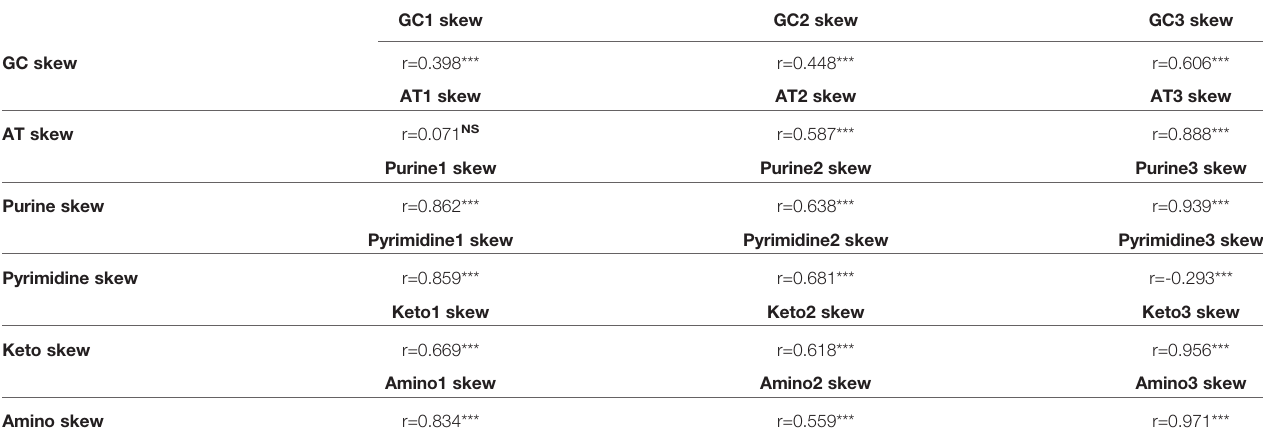
TABLE 3 | The correlations between the overall nucleotide skew and the nucleotide skew at the speci fi c codon position at the gene level.